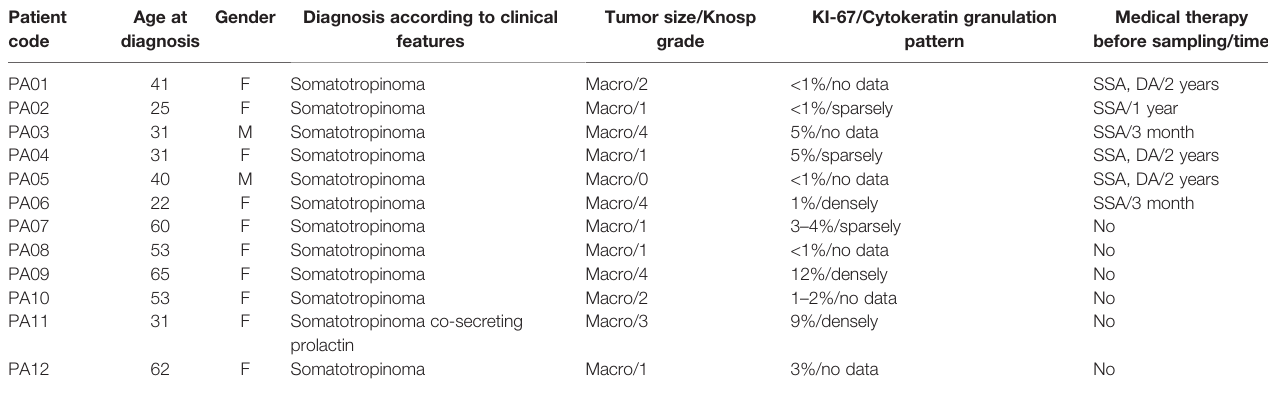
TABLE 1 | Clinical characteristics of PitNET